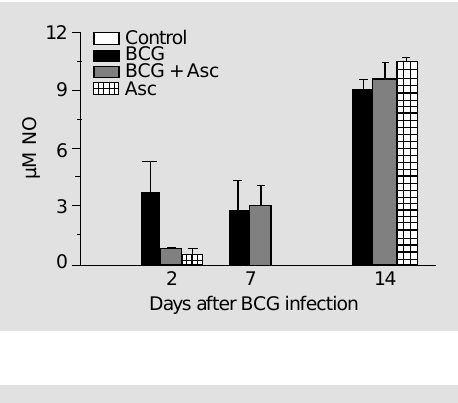
Figure 3 - Effect of Ascaris suum extract on TNF- a production in culture of peritoneal cells of C57Bl/6 mice during BCG infec- tion. Supernatants were har- vested 48 h after stimulation with 10 µg/ml of BCG antigen and measured by two-sandwich ELISA. Kinetic TNF- a data are expressed as mean ± SD (pg/ ml) of one representative experi- ment with quadruplicate meas- urements per data point. *P<0.05 compared to BCG and BCG + Asc groups (Student t -test).